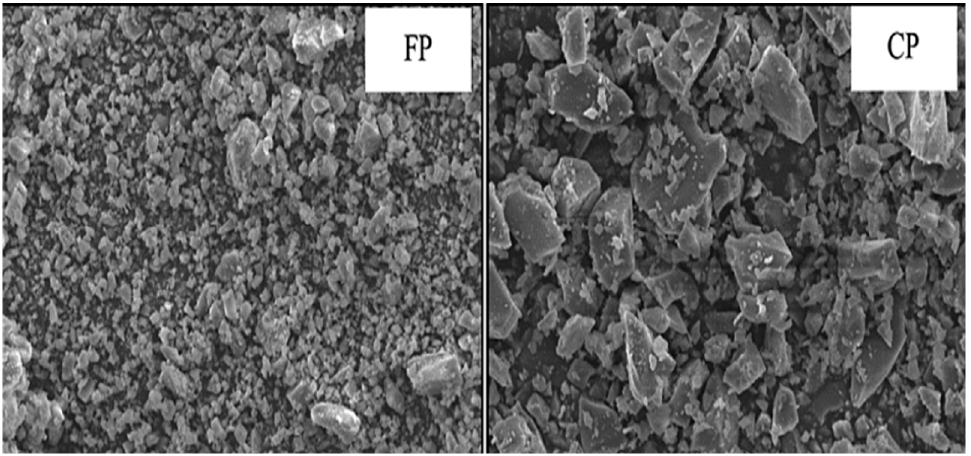
Figure 14. SEM image of waste glass power [128].